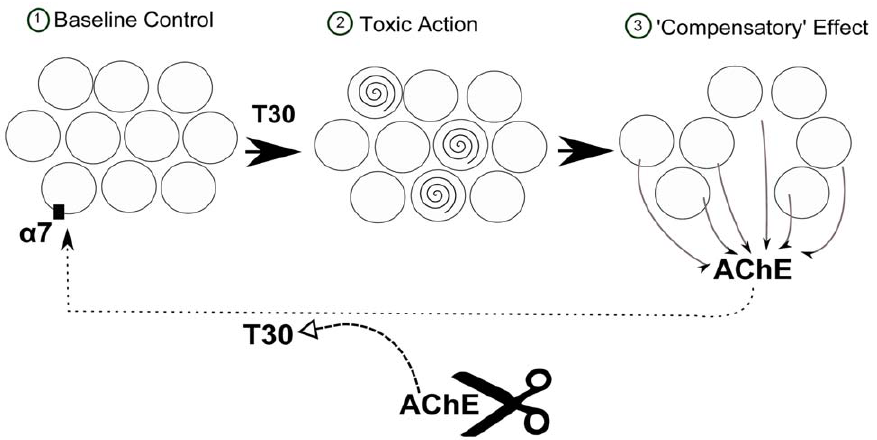
Figure 8. Possible scheme of the effects of T30 on PC12 cells. The population of cells (1) is treated with AChE C-terminus peptide of 30 amino acids (T30), causing a reduction of 30% of the population (2) and a consequent increase in AChE release from the 70% of the extant population as a ‘compensatory’ effect (3). The released AChE could be cleaved to yield T30 which then would act at the a 7-nAChR, completing a feed-forward cycle of toxicity.